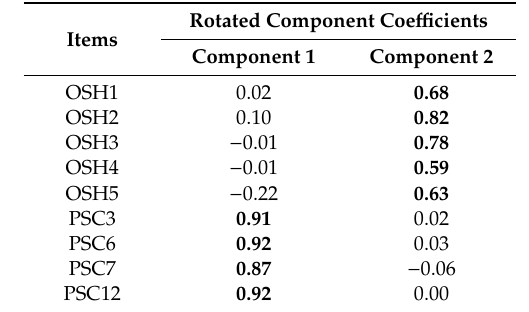
Table A3. Rotated pattern matrix factor loadings for factor analysis with direct oblimin rotation for two components. Rotated Component Coe ffi cients Items